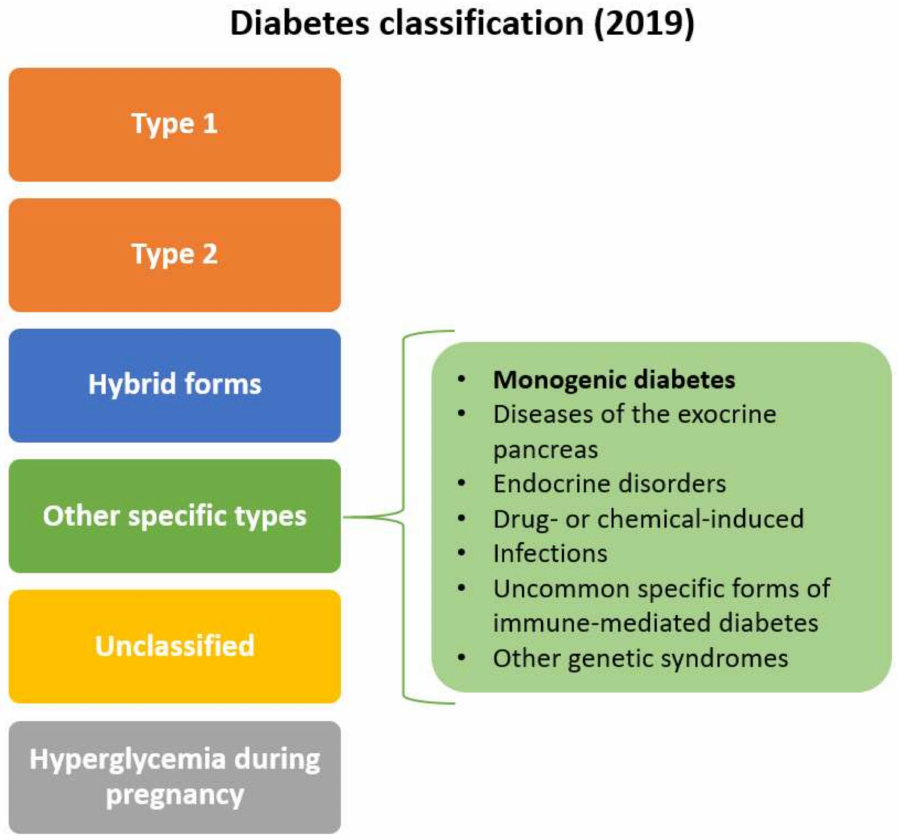
Figure 1. Classification system of diabetes cases (based on WHO, 2019 [5]). The monogenic diabetes subclass was additionally divided into monogenic defects of β -cell function, monogenic defects in insulin action and other genetic syndromes associated with diabetes (Figure 2). Clinical manifestation of monogenic defects in β -cell function include maturity-onset diabetes of the young (MODY) and other genetic syndromes where insulin-deficient diabetes is associated with additional clinical features